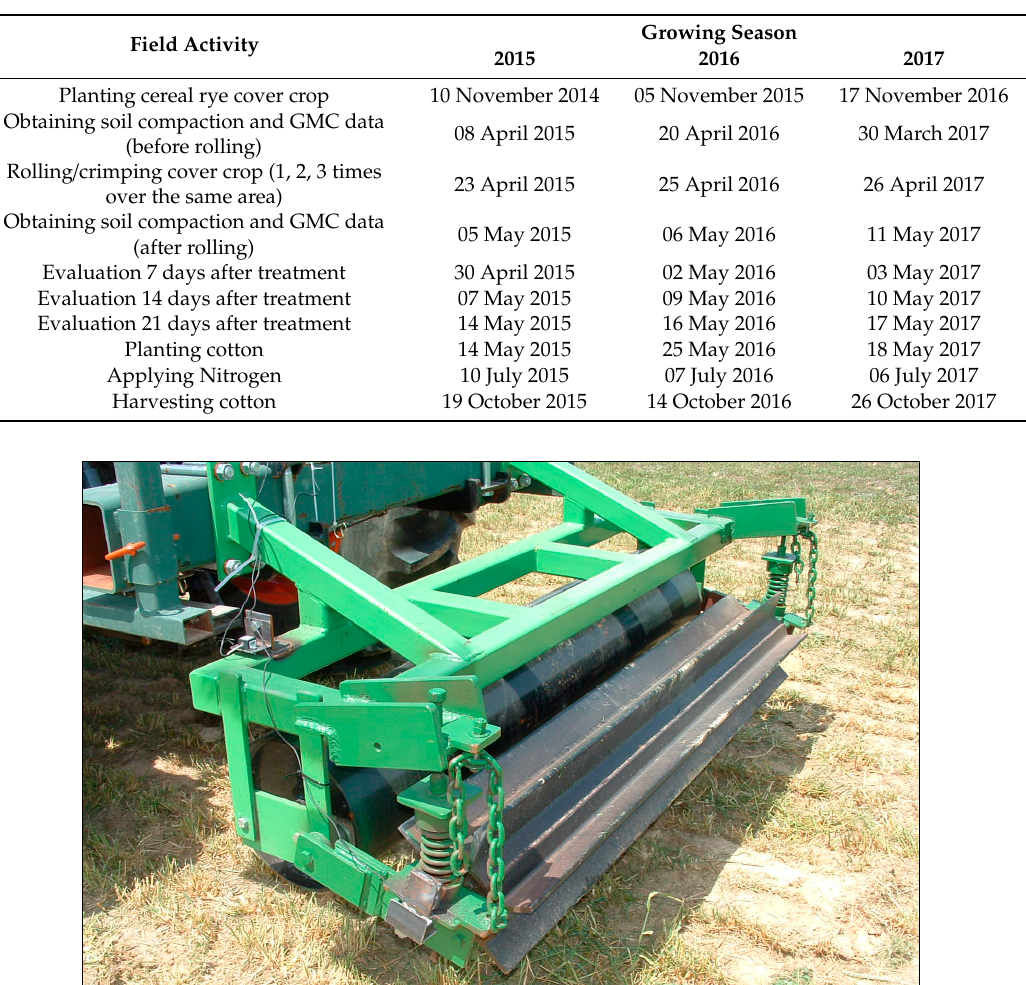
Table 1. Field activities during the 2015, 2016, and 2017 growing seasons at the E.V Smith Research Center in Central Alabama.